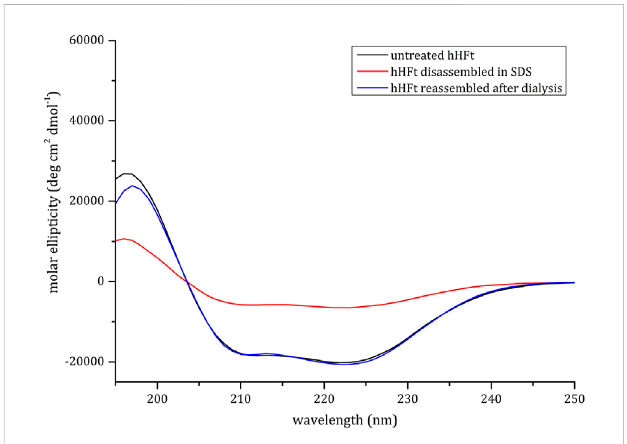
FIGURE 2 CD spectra ofhHFt during theSDStreatment. Black line :